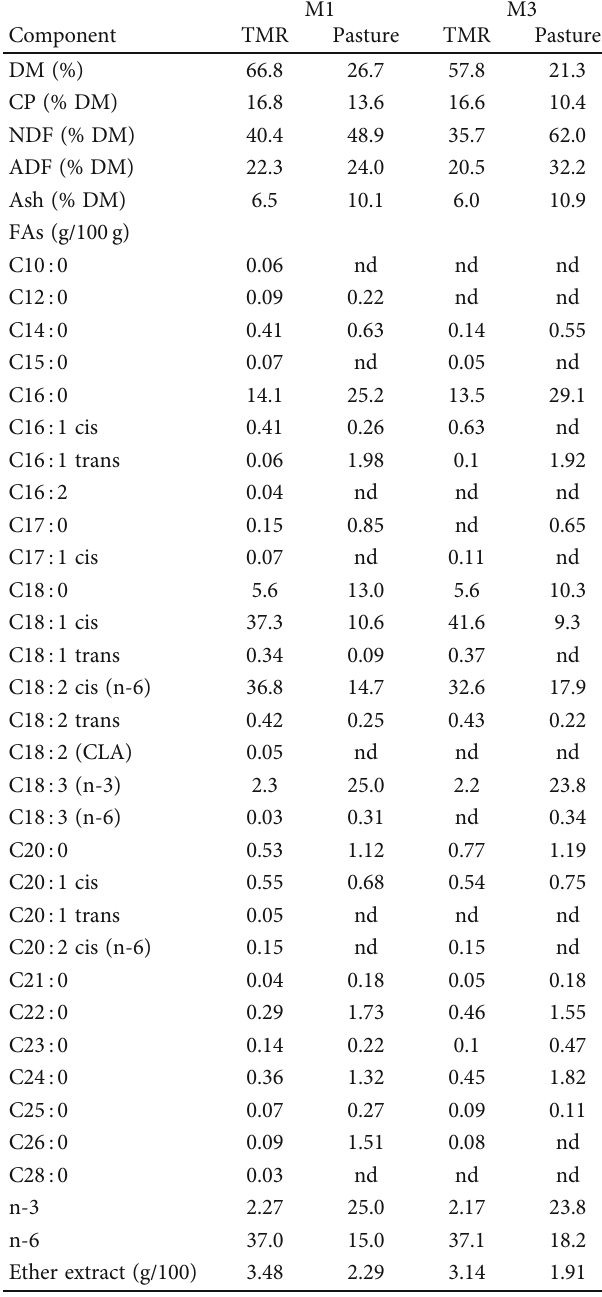
Table 1: Chemical composition and fatty acid pro fi le of total mixed ration (TMR) and pasture in two moments (M1 and M3) of the